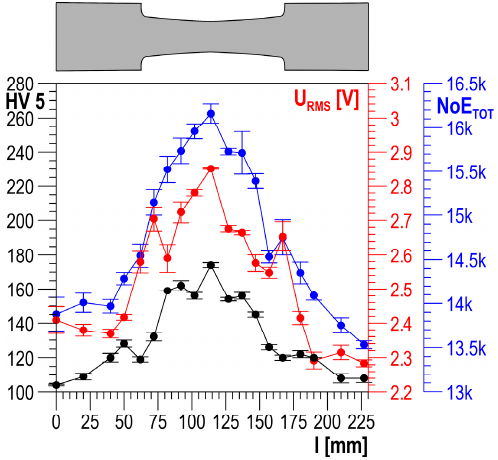
Figure 7. Distribution of HV5, root mean square (RMS), and NoE TOT along the S235 steel specimen length.